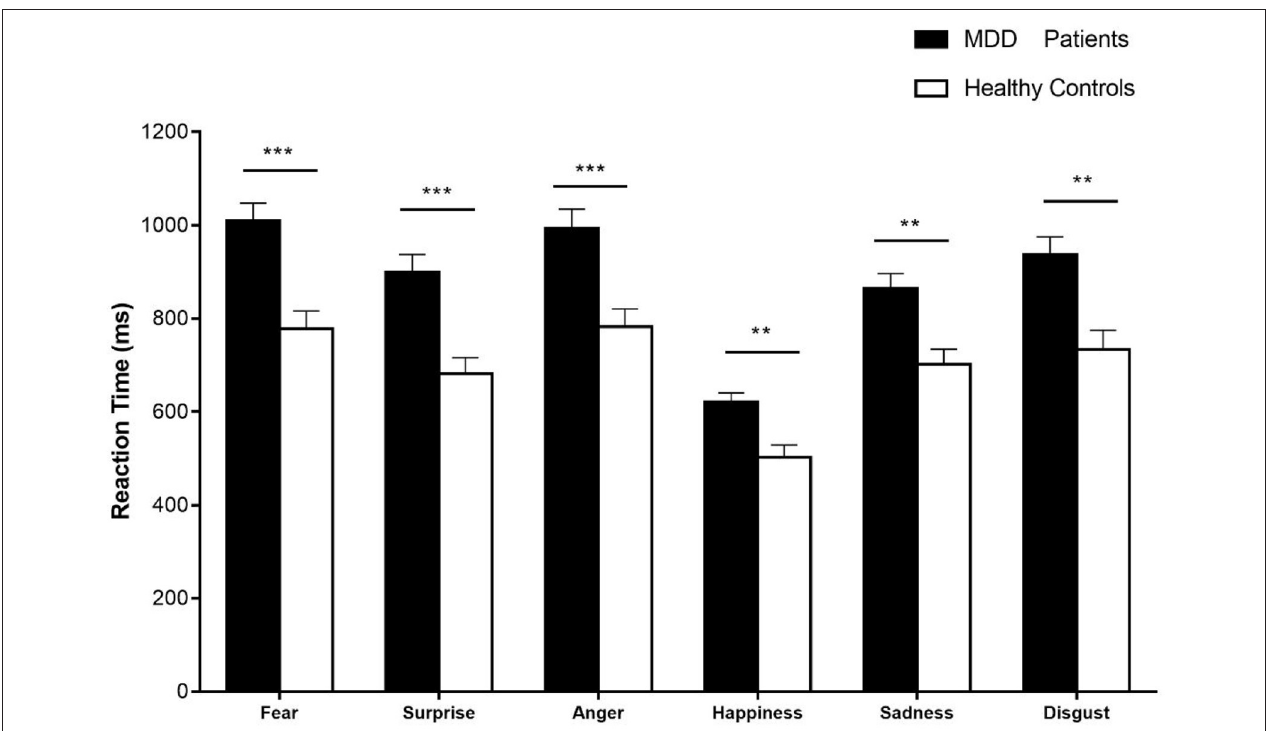
FIGURE 7 | The reaction time of six basic emotional expressions in patients with MDD and healthy controls. Error bars represent SEMs. * p < 0.05; ** p < 0.01; *** p <